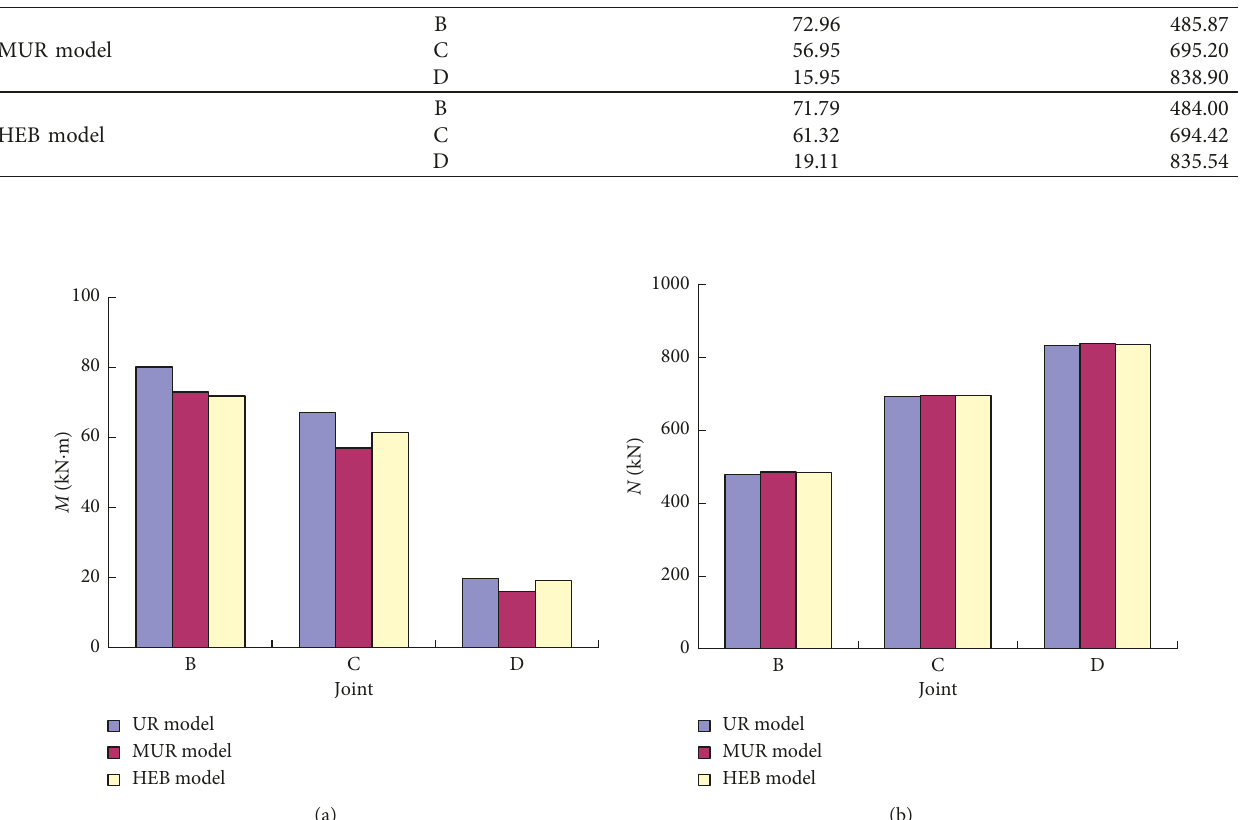
Figure 14: Comparison of inner force on joint sections. (a) Bending moment. (b) Axial